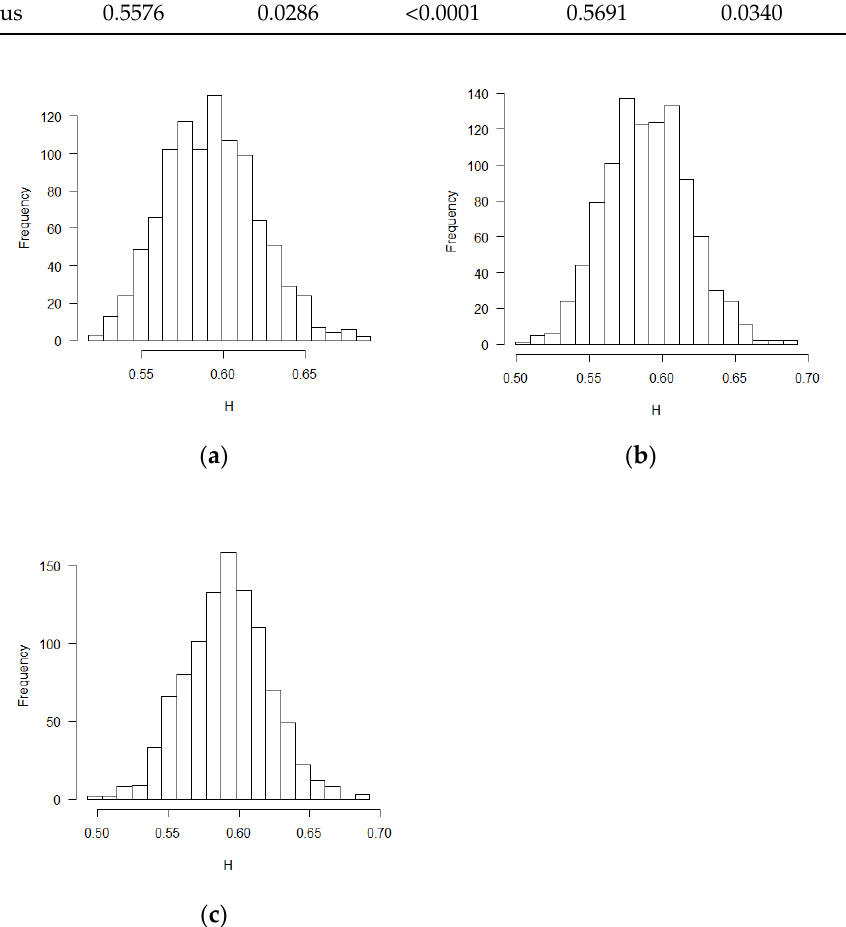
Figure 1. Histograms for estimated H values (BR design, ε ’s ~ increments of FBM, MLE method): ( a ) no covariate, ( b ) two discrete covariates, ( c ) two continuous covariates.